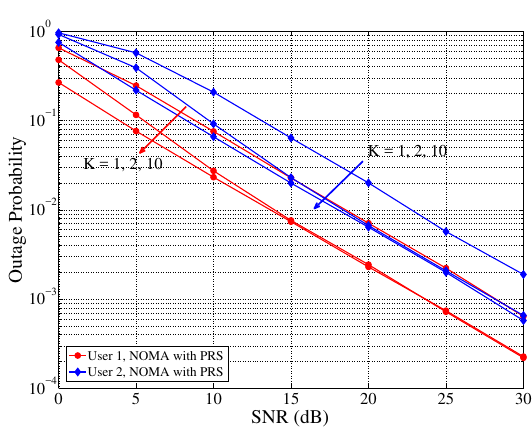
Figure 1. Outage probability of NOMA with PRS.